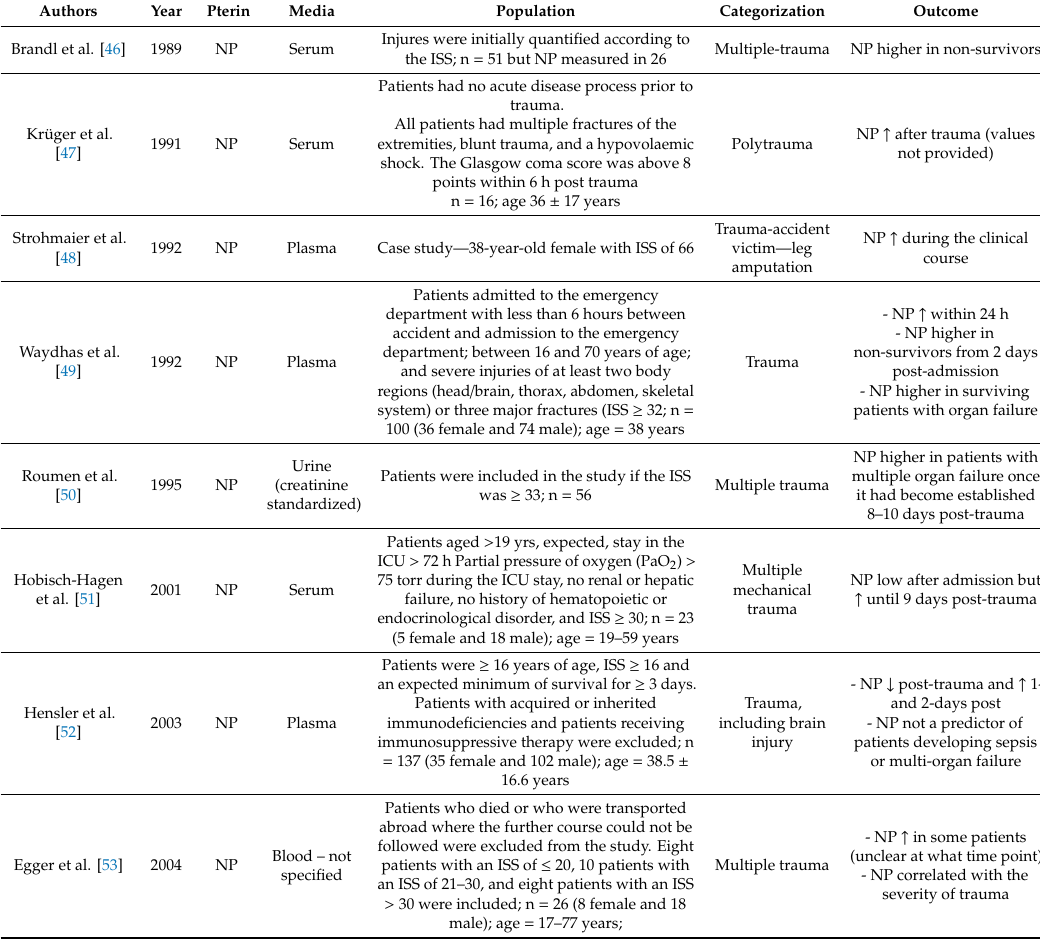
Table 4. Studies measuring pterins following multiple trauma or bone